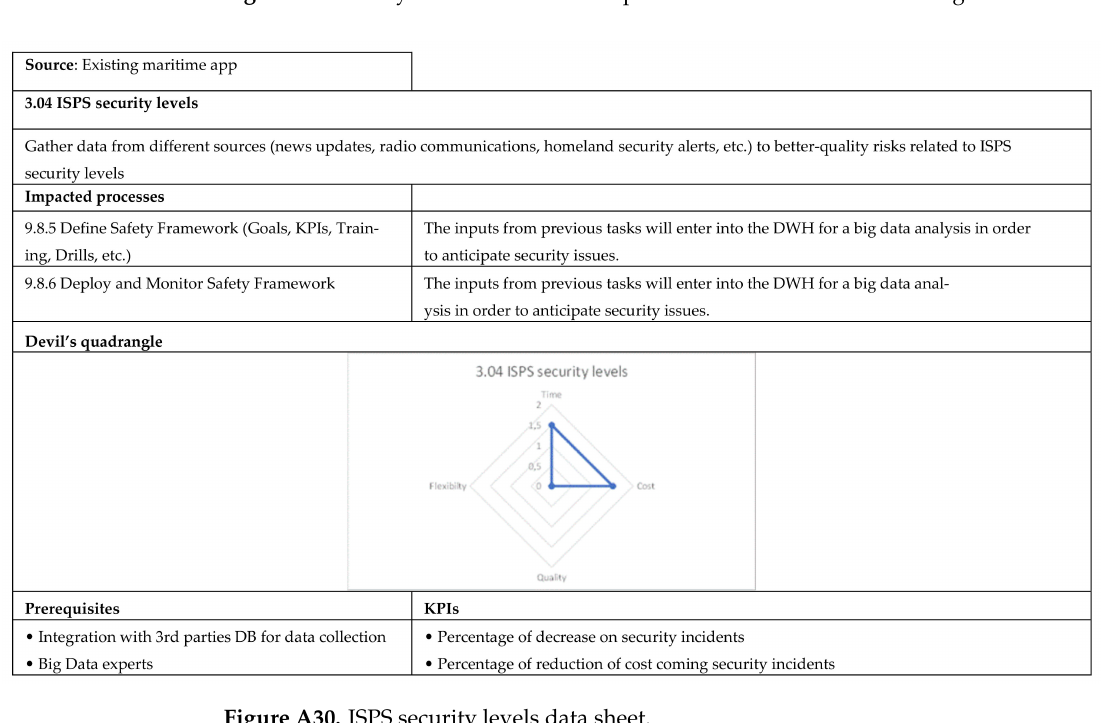
Figure A29. Analysis of data on consumption and emissions for bunkering selection data sheet.